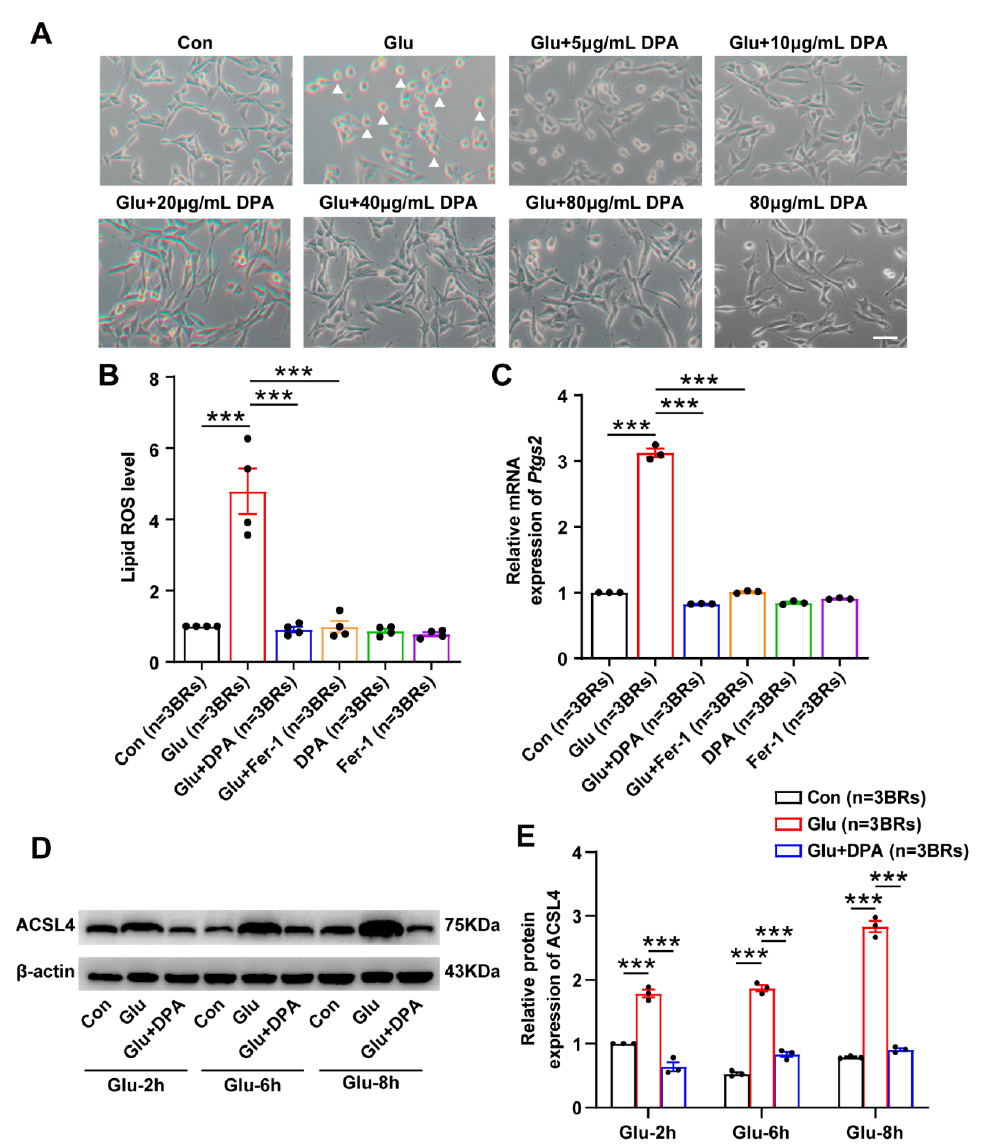
Figure 3. DPA inhibits glutamate-induced neuronal ferroptosis in vitro. ( A ) Representative phase contrast images showing the effects of DPA by different concentrations (5, 10, 20, 40 and 80 μ g/mL) on neuronal ferroptosis induced by 5 mmol/L of glutamate for 8 h in HT22 cells. DPA was treated 2 h prior to glutamate treatment for 8 h in HT22 cells. The optimal concentration of DPA for the inhi- bition of neuronal ferroptosis in HT22 cells after glutamate exposure was 10 μ g/mL, which was employed for the subsequent experiments. Arrows indicate the dead neurons. Scale bar indicates 50 μ m. ( B – E ) The effects of DPA on ferroptosis-associated indices including lipid ROS, Ptgs2 mRNA and protein expression levels of ACSL4 in glutamate-induced ferroptosis in HT22 neuronal cells. The concentrations of DPA and Fer-1 (a specific ferroptosis inhibitor) were 10 μ g/mL and 12.5 μ mol/L, respectively. Regarding the detections of lipid ROS and Ptgs2 mRNA, HT22 cells were treated with DPA or Fer-1 2 h prior to glutamate exposure for 8 h while the cell samples were col- lected for determination of ACSL4 protein expression following pretreatment with DPA for 2 h and glutamate challenge at different time points (2 h, 6 h and 8 h). All the data were expressed as mean ± SEM ( n = 3 independent biological replicates). *** p < 0.001. Abbreviation : Glu, glutamate; DPA, D-penicillamine; Fer-1, ferrostatin-1; Ptgs2 , prostaglandin-endoperoxide synthase 2; lipid ROS, lipid